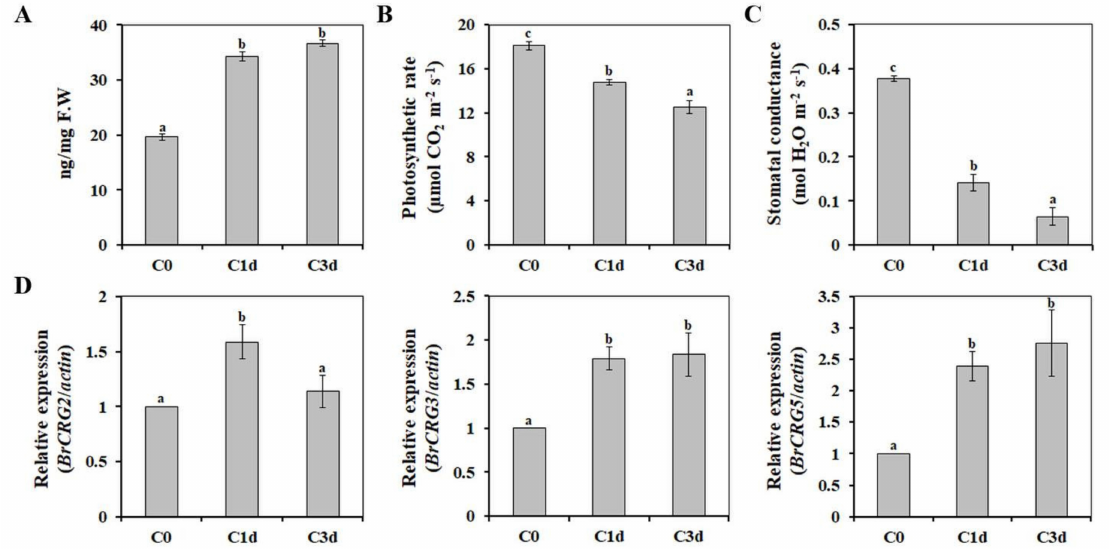
Figure 1. Physiological response to cold stress in heading type Kimchi cabbage. The changes in levels of proline ( A ), photosynthetic rate ( B ), stomatal conductance ( C ), and selected gene expression ( D ) after cold treatment were determined. The data are presented as mean ± SE. Values with different letters are significantly different, according to Duncan’s multiple range test. C0, plants grown at 20 ◦ C (control plants); C1d and C3d, plants subjected to cold stress (10 ◦ C) for 1 day and 3 days,